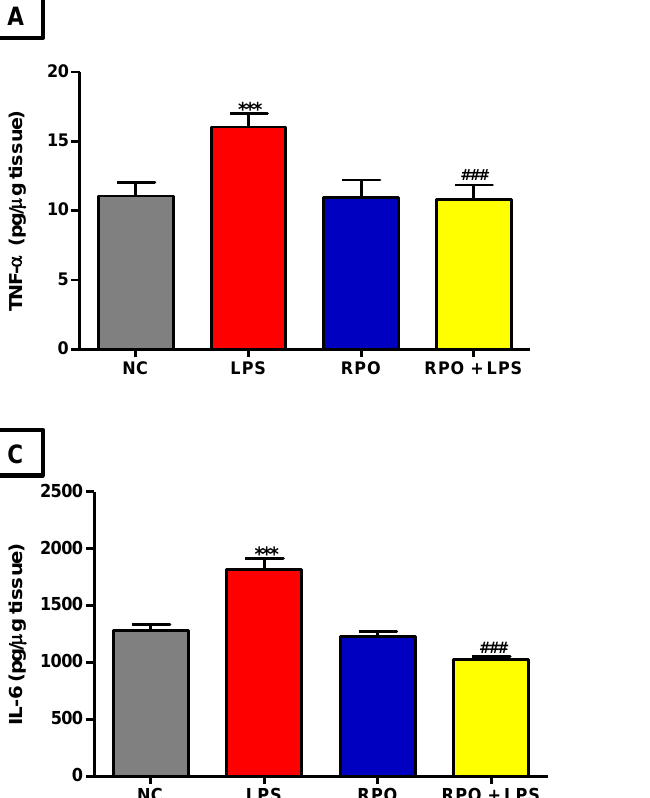
Figure 5. RPO suppresses release of pro-inflammatory cytokines in LPS-induced rats. RPO reduced ( A ) TNF- α ( B ) IL-1 β ( C ) IL-6 and showed no effect on ( D ) IL-10 levels in the liver. Data are mean ± SEM ( n = 8–10). *** p < 0.001 as significant difference compared with NC. ### p < 0.001 as significant difference compared with LPS. LPS (lipopolysaccharide), NC (normal control), RPO (red palm oil).